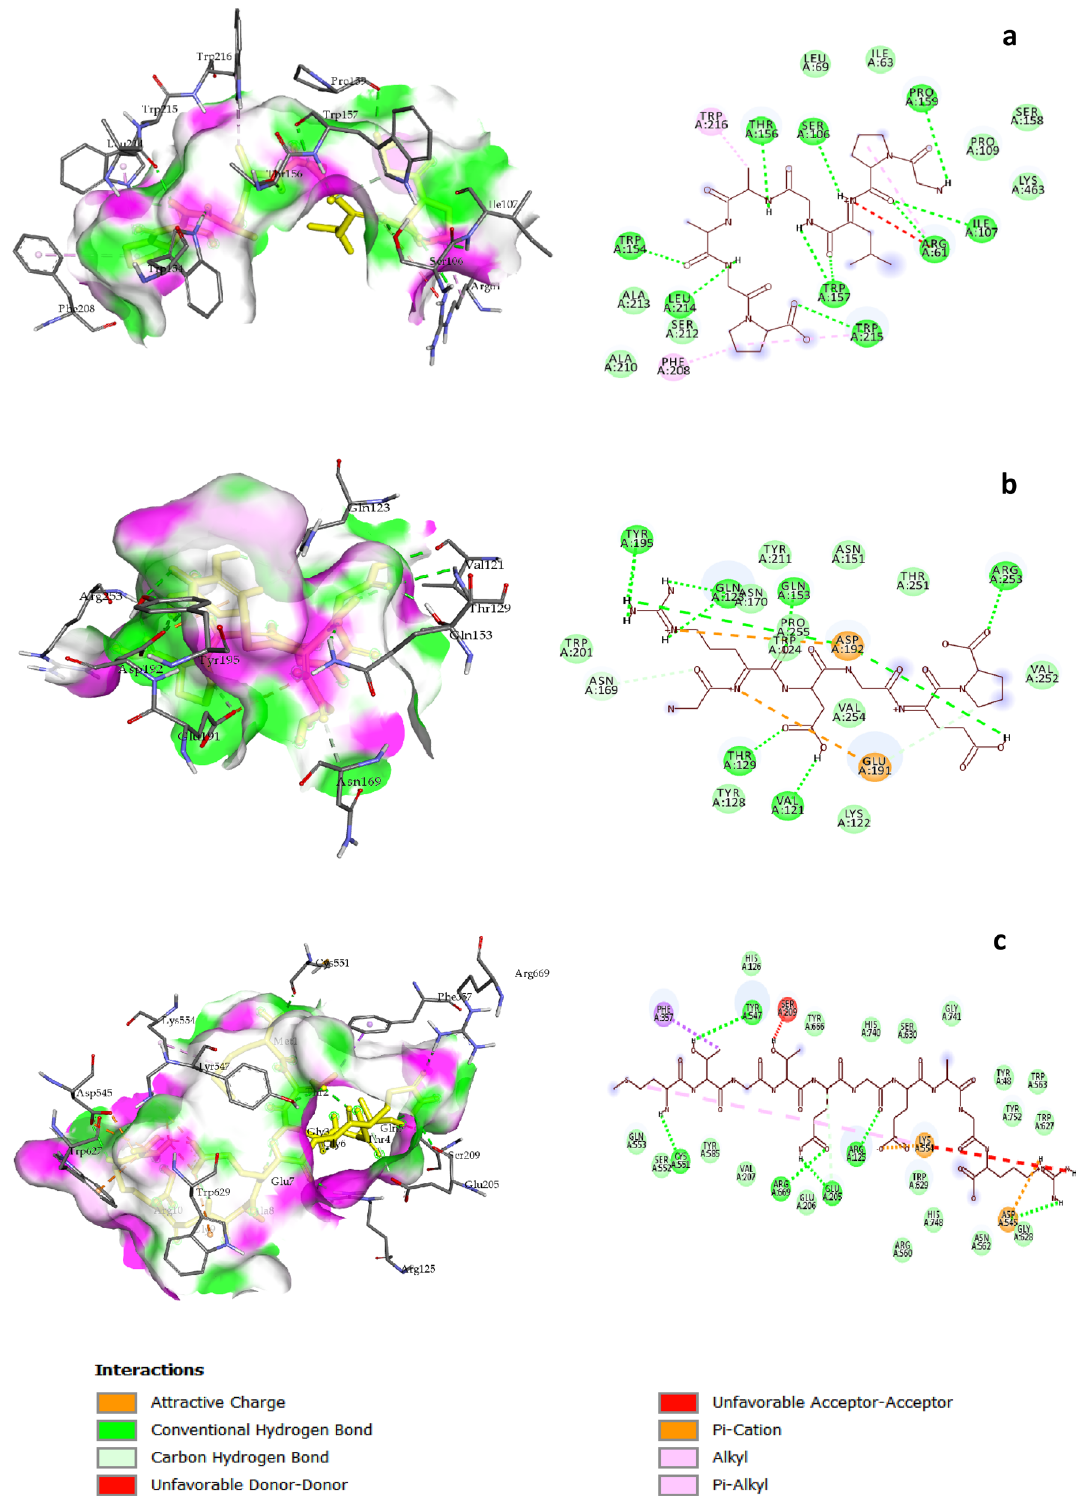
Figure 6. Computational simulation of the docked peptides on the human dipeptidyl peptidase IV (DPP-IV) structure with their interactions. ( a ) GPLGAAGP (P1), ( b ) GRDGEP (P2), and ( c ) MTGTQGEAGR